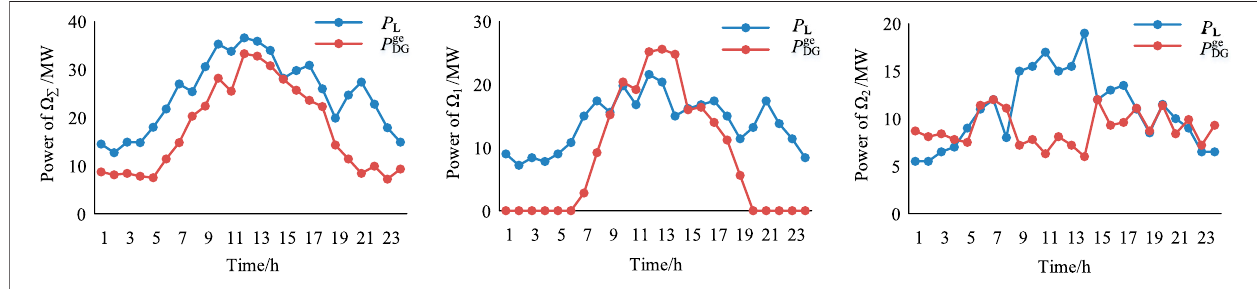
FIGURE 4 | Scenario 1: daily curve of the available output power of DGs and consumption power of the load.